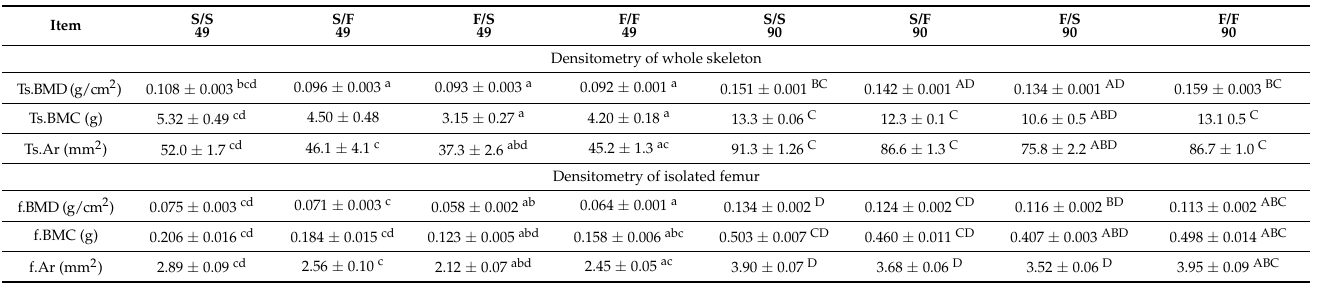
Table 1. DXA parameters of the entire skeleton and femur.